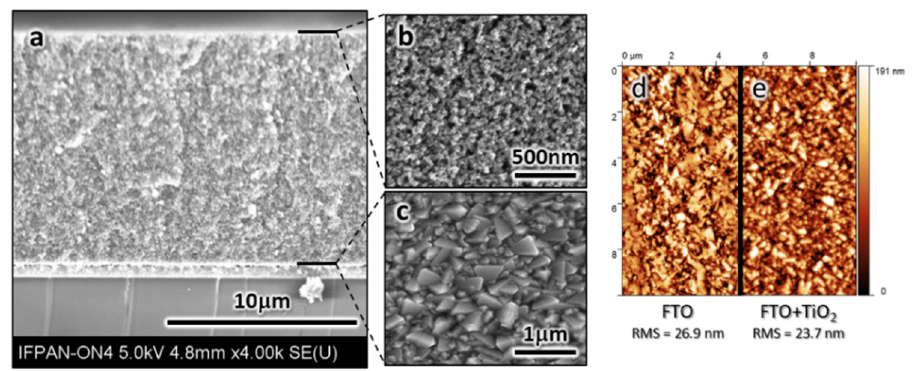
Figure 4. SEM images of ( a ) the intersection of the photoanode: glass, FTO, TiO 2 compact and 11 µm TiO 2 mesoporous layers, ( b ) the morphology of the mesoporous TiO 2 film and ( c ) the TiO 2 compact layer on the FTO. AFM images of ( d ) the bare FTO and ( e ) the TiO 2 electron blocking layer on the FTO.